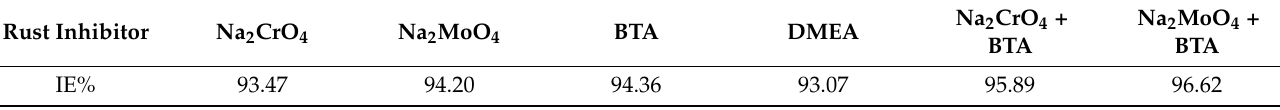
Table 8. Inhibition efficiency of the rust